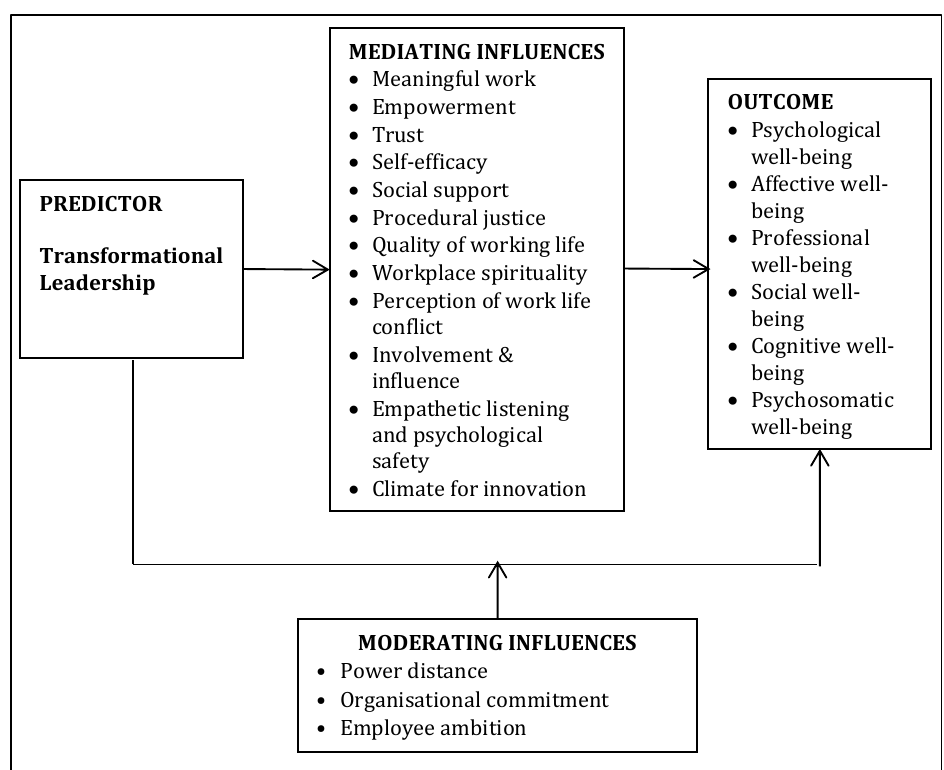
Figure 2: The Relationship between Transformational Leadership and Employee Well-